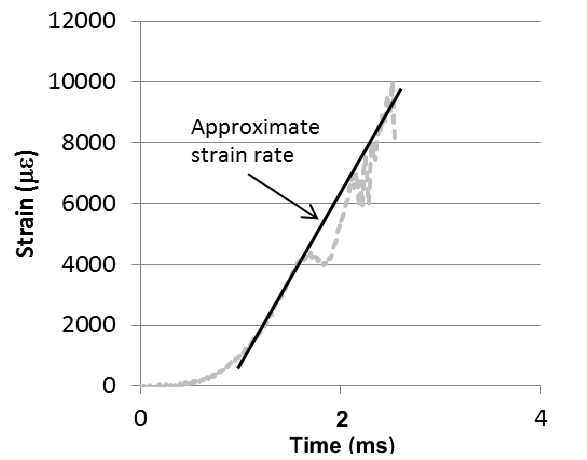
Figure 6. Determination of approximate strain